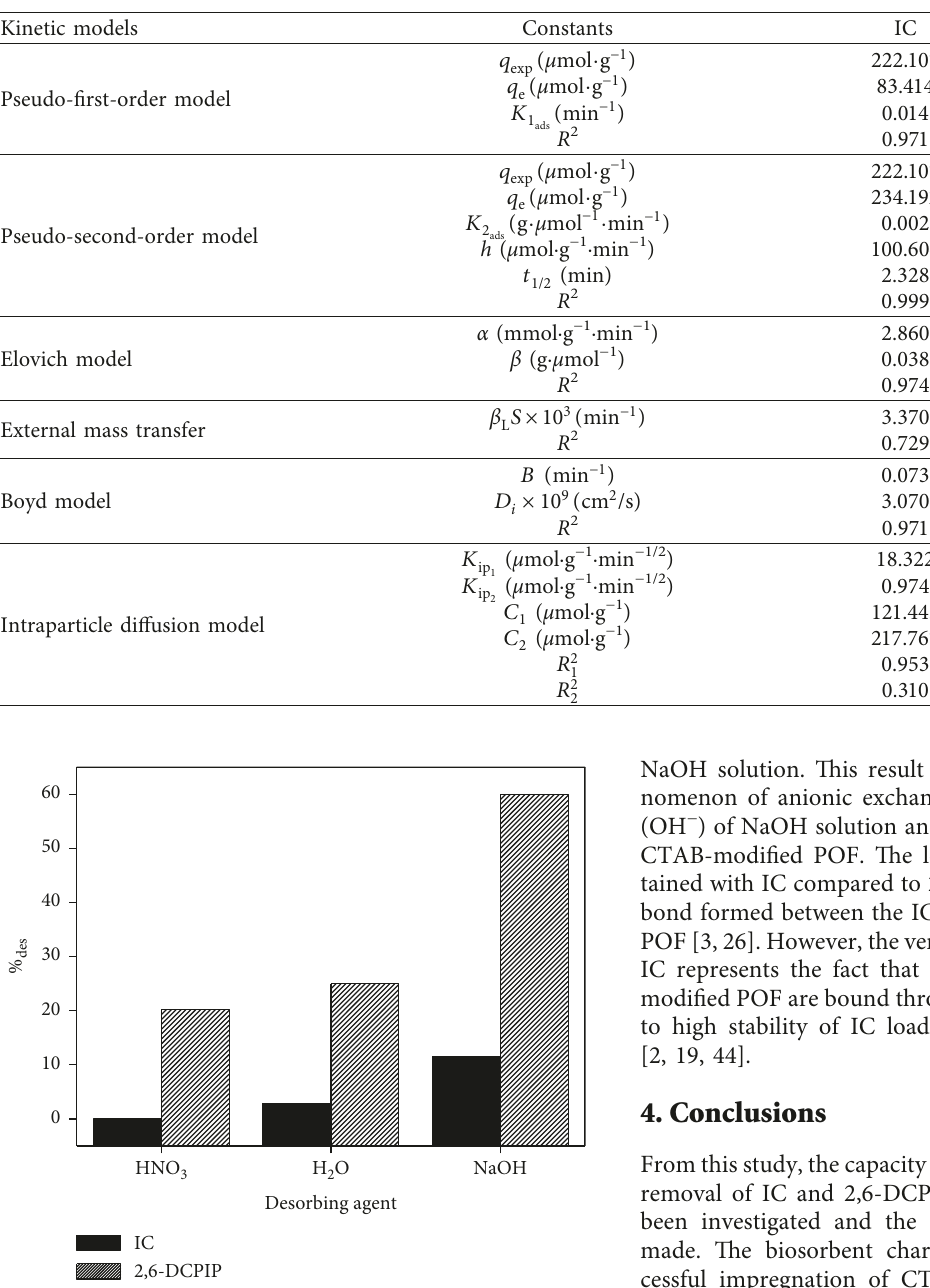
Table 4: Pseudo-first order, pseudo-second-order, Elovich, external mass transfer, Boyd, and intraparticle diffusion parameters for IC and 2,6-DCPIP adsorption onto CTAB-modified POF.